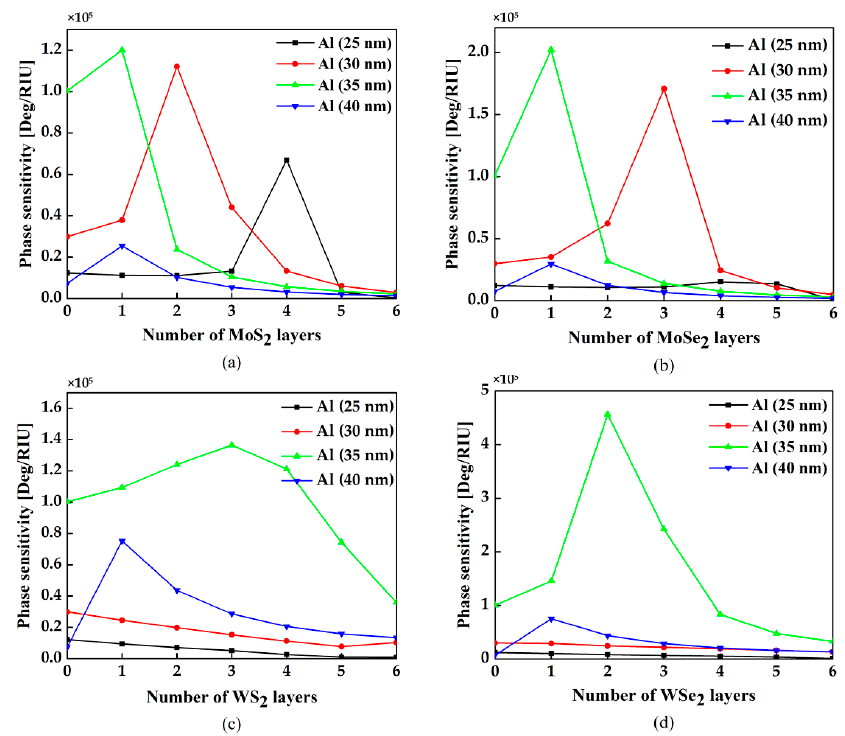
Figure 7. Variation of the angular sensitivity as a function of number of MX 2 layers with various thickness of Al thin film, ( a ) MoS 2 , ( b ) MoSe 2 , ( c ) WS 2 , and ( d ) WSe 2 .